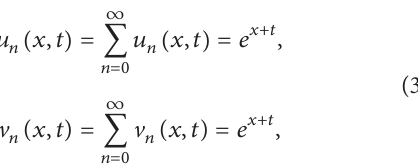
and so on. The 𝑛 -order term approximate solution, in series form, is given